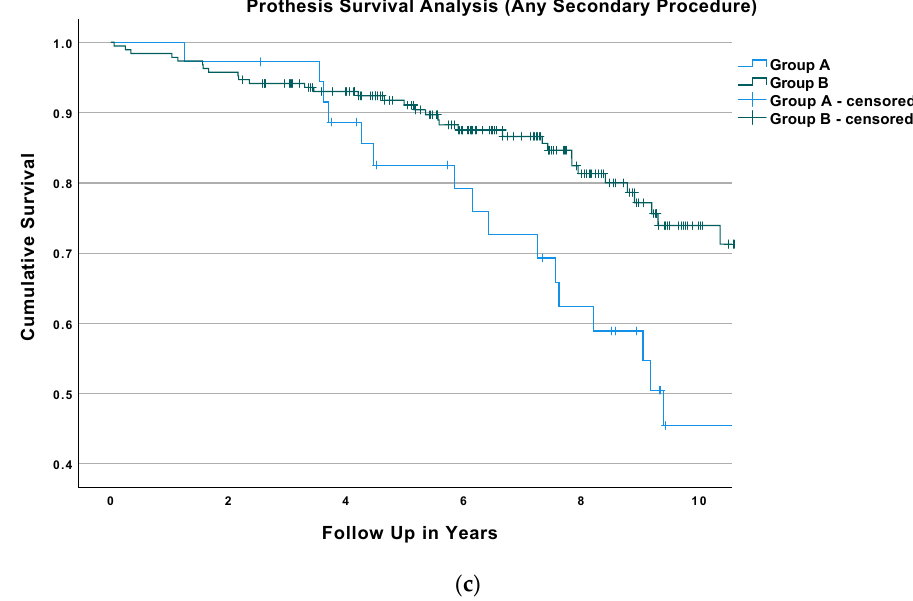
Figure 2. ( a ). Results of the Kaplan–Meier Survival analysis of both study groups with reoperation as the endpoint. ( b ) Results of the Kaplan–Meier Survival analysis of both study groups with revision as the endpoint. ( c ) Results of the Kaplan–Meier Survival analysis of both study groups with any secondary surgery as the endpoint.